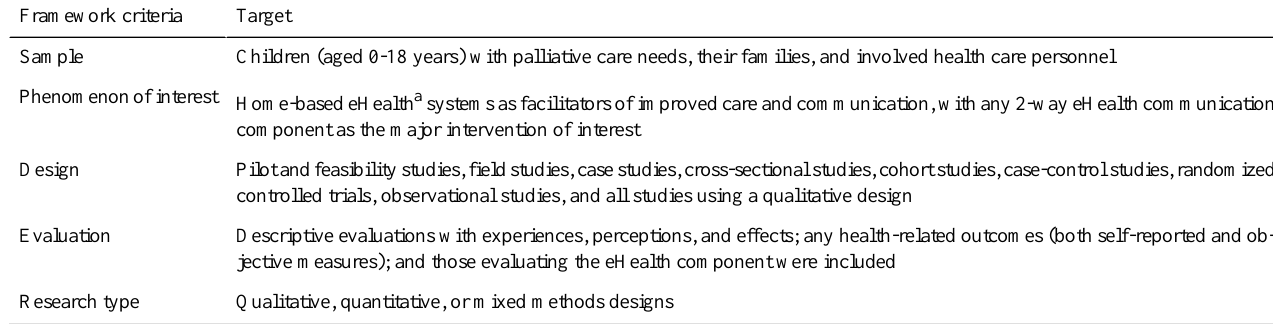
Table 1. Sample, phenomenon of interest, design, evaluation, and research type framework used to identify